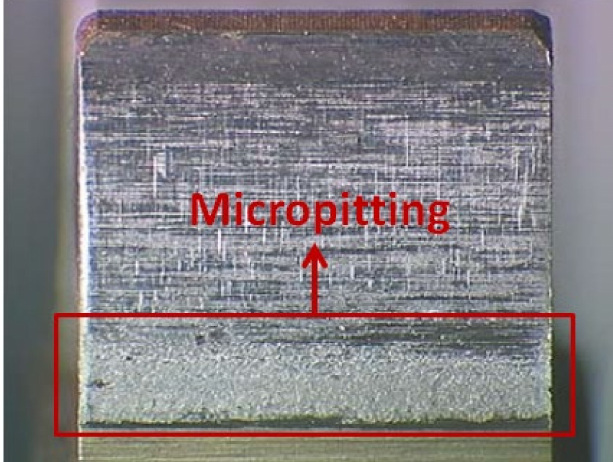
Figure 2. Gear tooth showing micropitting damage in the root region. (Design Unit, Newcastle University from reference